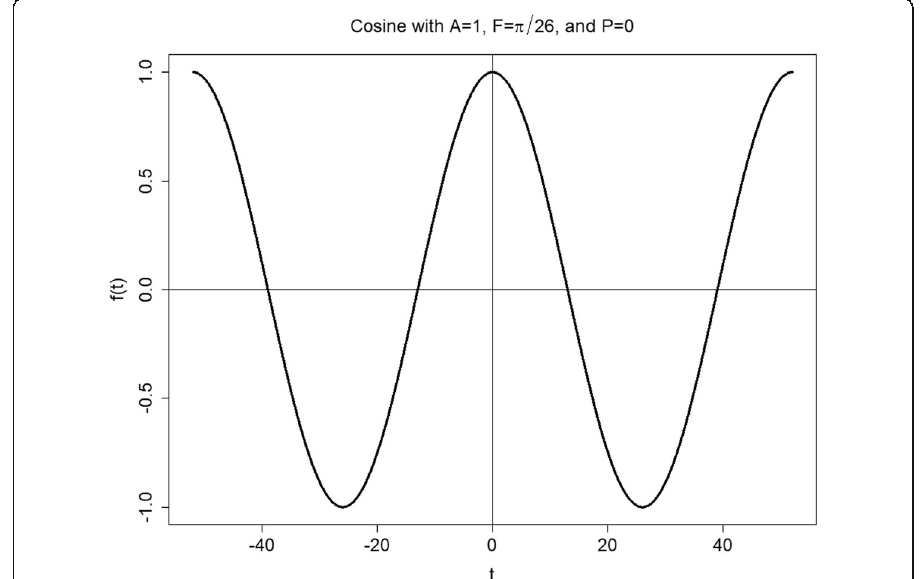
Fig. 12 Cosine with amplitude 1 and period 52